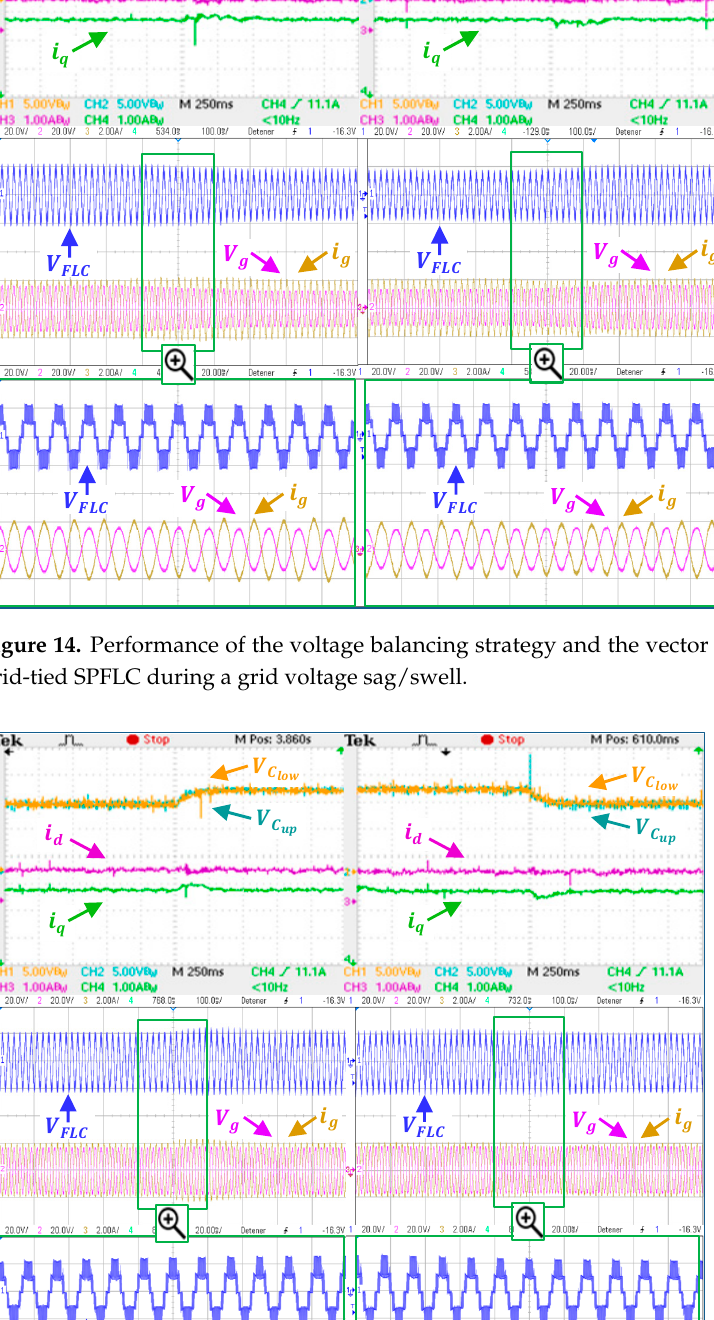
Figure 16. Fluke 43B-based power quality analysis of grid-tied SPFLC waveforms without the activation of the DC-link split capacitors’ voltage balancing. ( a ) SPFLC output voltage 𝑉 (cid:3007)(cid:3013)(cid:3004) and the resulting grid current 𝑖 (cid:3034) from the vector control technique; ( b ) grid powers, grid factors, 𝑉 (cid:3034) and 𝑖 (cid:3034) ; ( c ) spectrum of 𝑉 (cid:3007)(cid:3013)(cid:3004) ; and ( d ) spectrum of 𝑖 (cid:3034) .